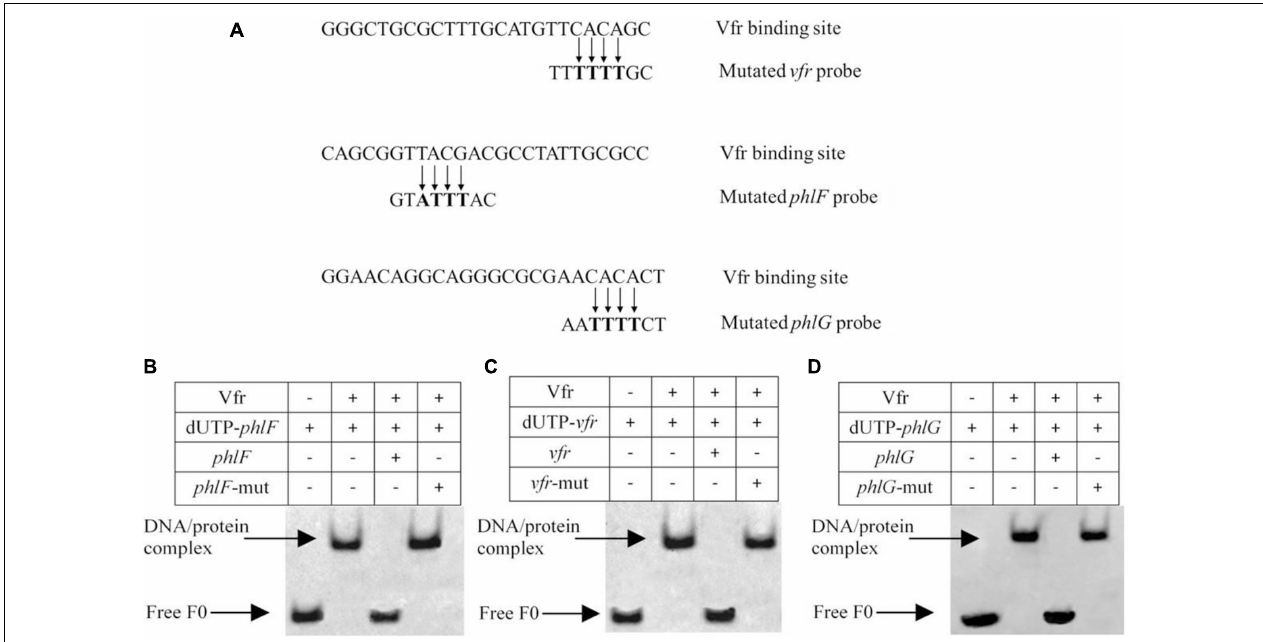
FIGURE 6 | EMSA assay confirming the binding of Vfr to derivative probes of vfr , phlF and phlG . (A) Comparison of the Vfr binding consensus sequence of the target genes with the mutated Vfr binding sites used in EMSA. (B–D) For competition assays, a 200-fold excess of unlabeled wild-type or mutated oligonucleotide was added to the reaction mixture prior to the addition of 0.02 µ M labeled